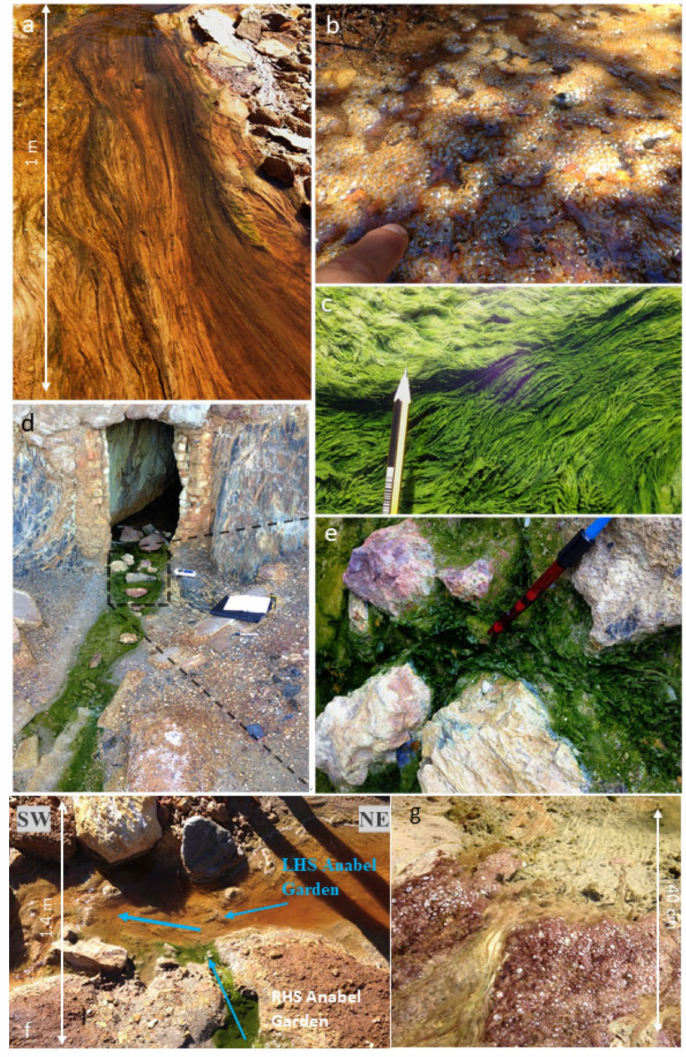
Figure 6. Evidence of microbial activity at the field sites in different spring locations of the Peña de Hierro area. ( a ) photosynthetic filamentous algae (streamers) established at the emergence of Nuria Spring. ( b ) Gas bubbles contained nano ferric oxides, generate on the Right spring, most likely due to biological metabolism. ( c ) Vivid green photosynthetic algae colonizing the base on the Green Spring; ( d ) Entrance to the Green Spring showing the stream bed characterized by green algae which is enlarged ( e ) in image of green algae on Green spring with Eh probe. ( f ) The confluence of LHS Anabel’s Garden and RHS Anabel’s Garden, highlighting the sudden change in biological inhabitancy, potentially reflecting contrasting aqueous chemistries. ( g ) Purple globular biological activity on the Anabel’s Confluence